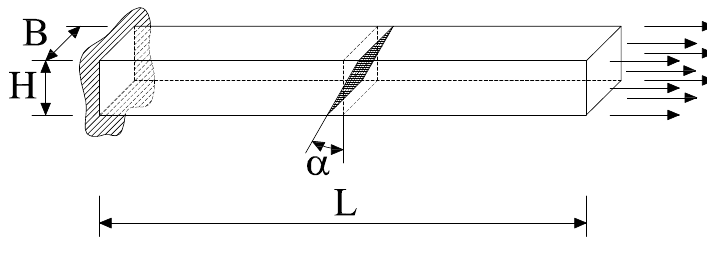
Figure 3. Typical